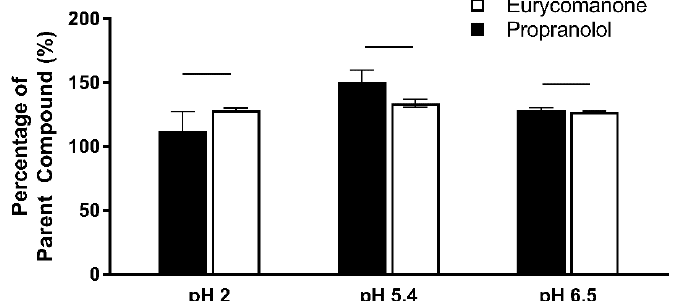
Figure 5. Eurycomanone showed high stability at pH 2, pH 5, and pH 6.5 and is comparable to the stability of propranolol. The values were plotted based on the mean ± standard deviation. There were no significant differences between propranolol and eurycomanone at all the pH levels tested. Line over bars indicates no significant difference when compared to eurycomanone ( p ≥ 0.05).